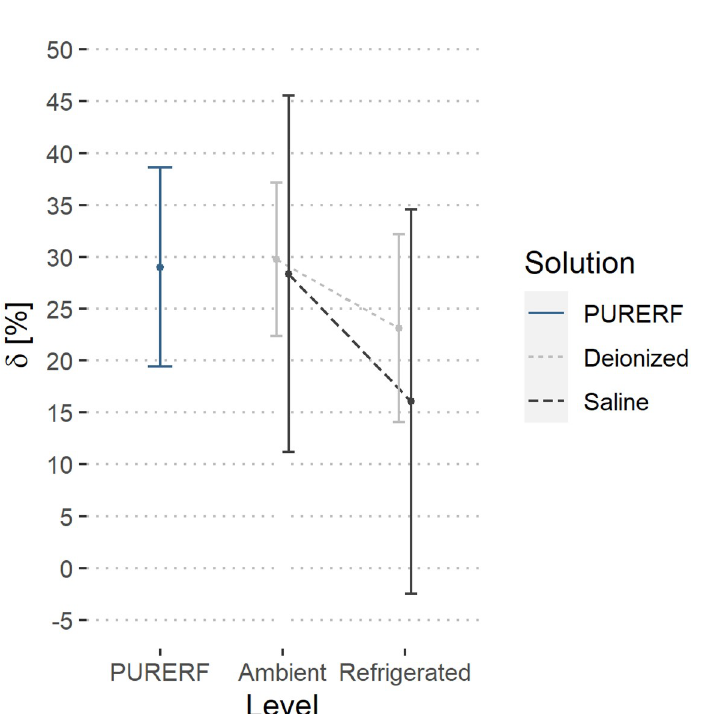
Fig 11. Estimated marginal averages of the index δ . The graph indicates no significant differences owing to the solution type or the temperature. Furthermore, there were no interactions between the factors.